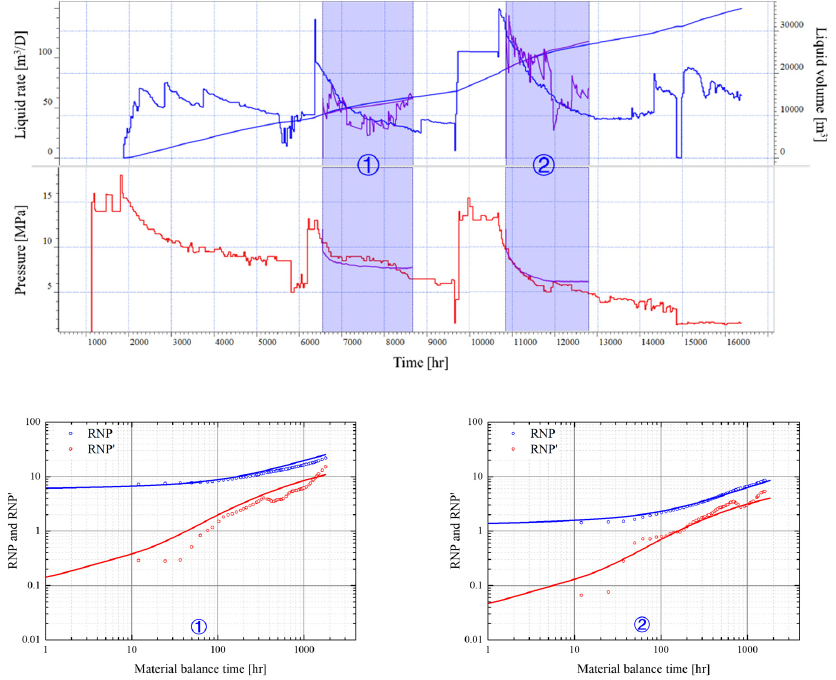
Figure 3. Historical comparison of passive well A and a log–log plot of RNP vs. tMB during the two corresponding